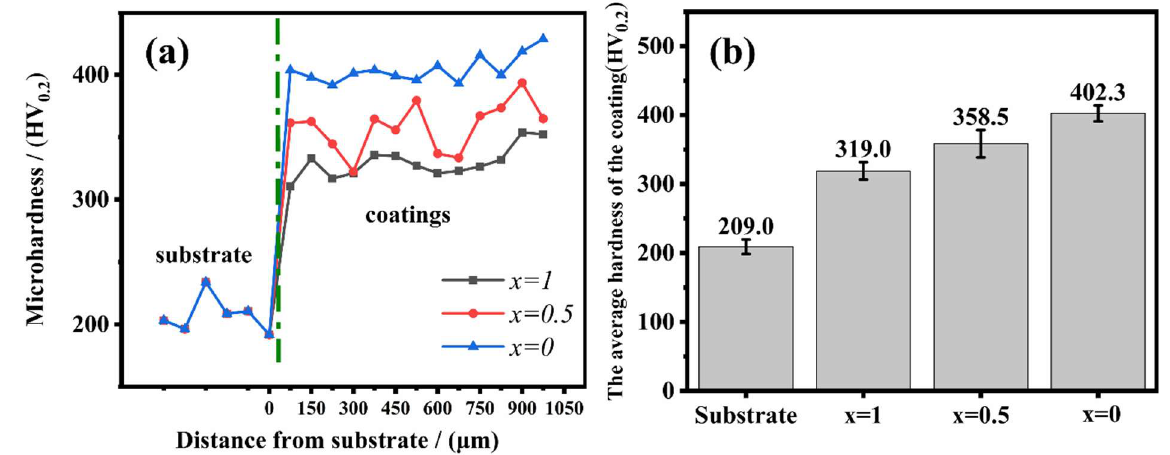
Figure 6. Hardness of Al x Ti 1− x ( x = 0, 0.5, 1) coatings: ( a ) Hardness distribution, ( b ) Average hardness.